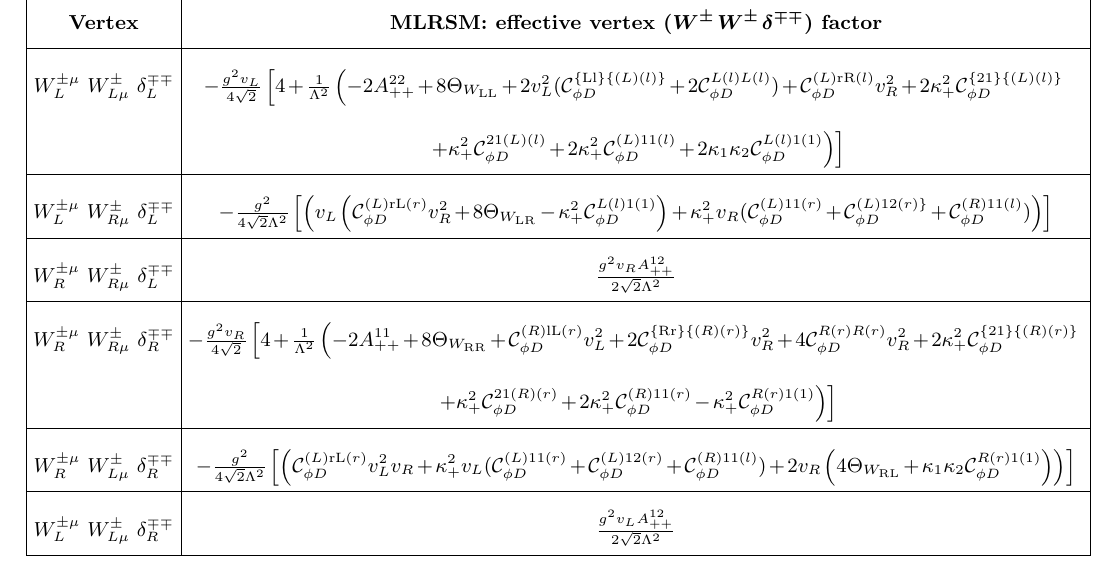
Table 39. MLRSM: coupling of doubly charged scalar ( (cid:14) (cid:6)(cid:6) ) with a pair of same signed charged gauge bosons ( W (cid:6) ).